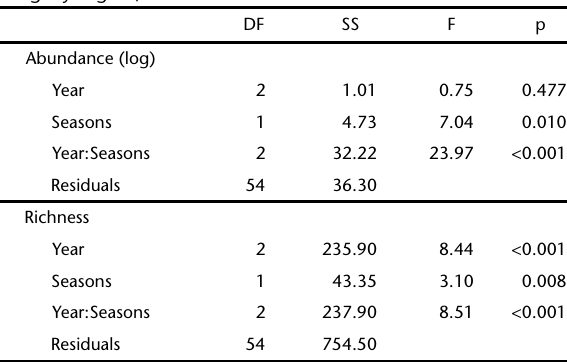
Table 3. Repeated measures ANOVA results for the variation in the abundance (log) and richness of Chironomidae community between seasons and among years at 10 stream sites in Alto Uruguay region, Rio Grande Sul.